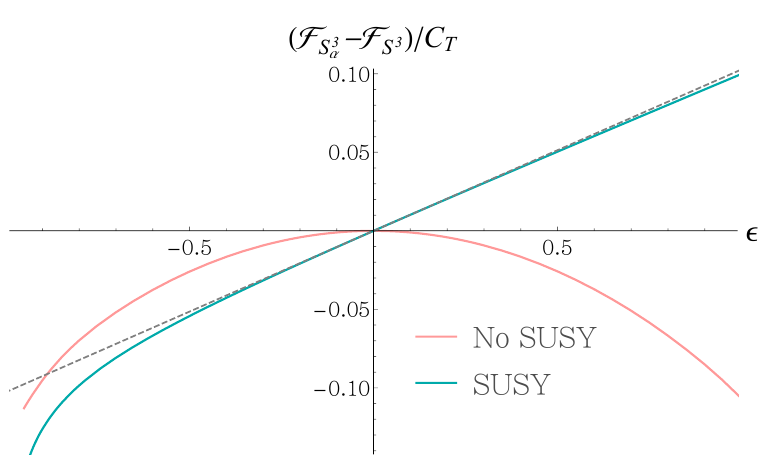
Figure 7 . A comparison between the supersymmetric free energy of a free chiral multiplet (cyan), F chiral (1 = 2 ; (cid:15) ), and the non-supersymmetric free energy of a theory of two conformally coupled real scalars and one Dirac fermion (pink). The dashed line depicts the linear holographic result in Equation